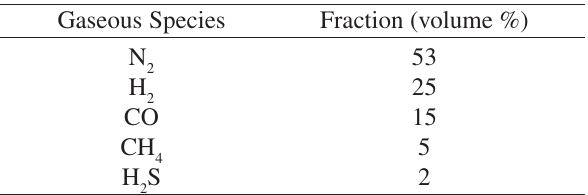
Table 1. Gaseous species